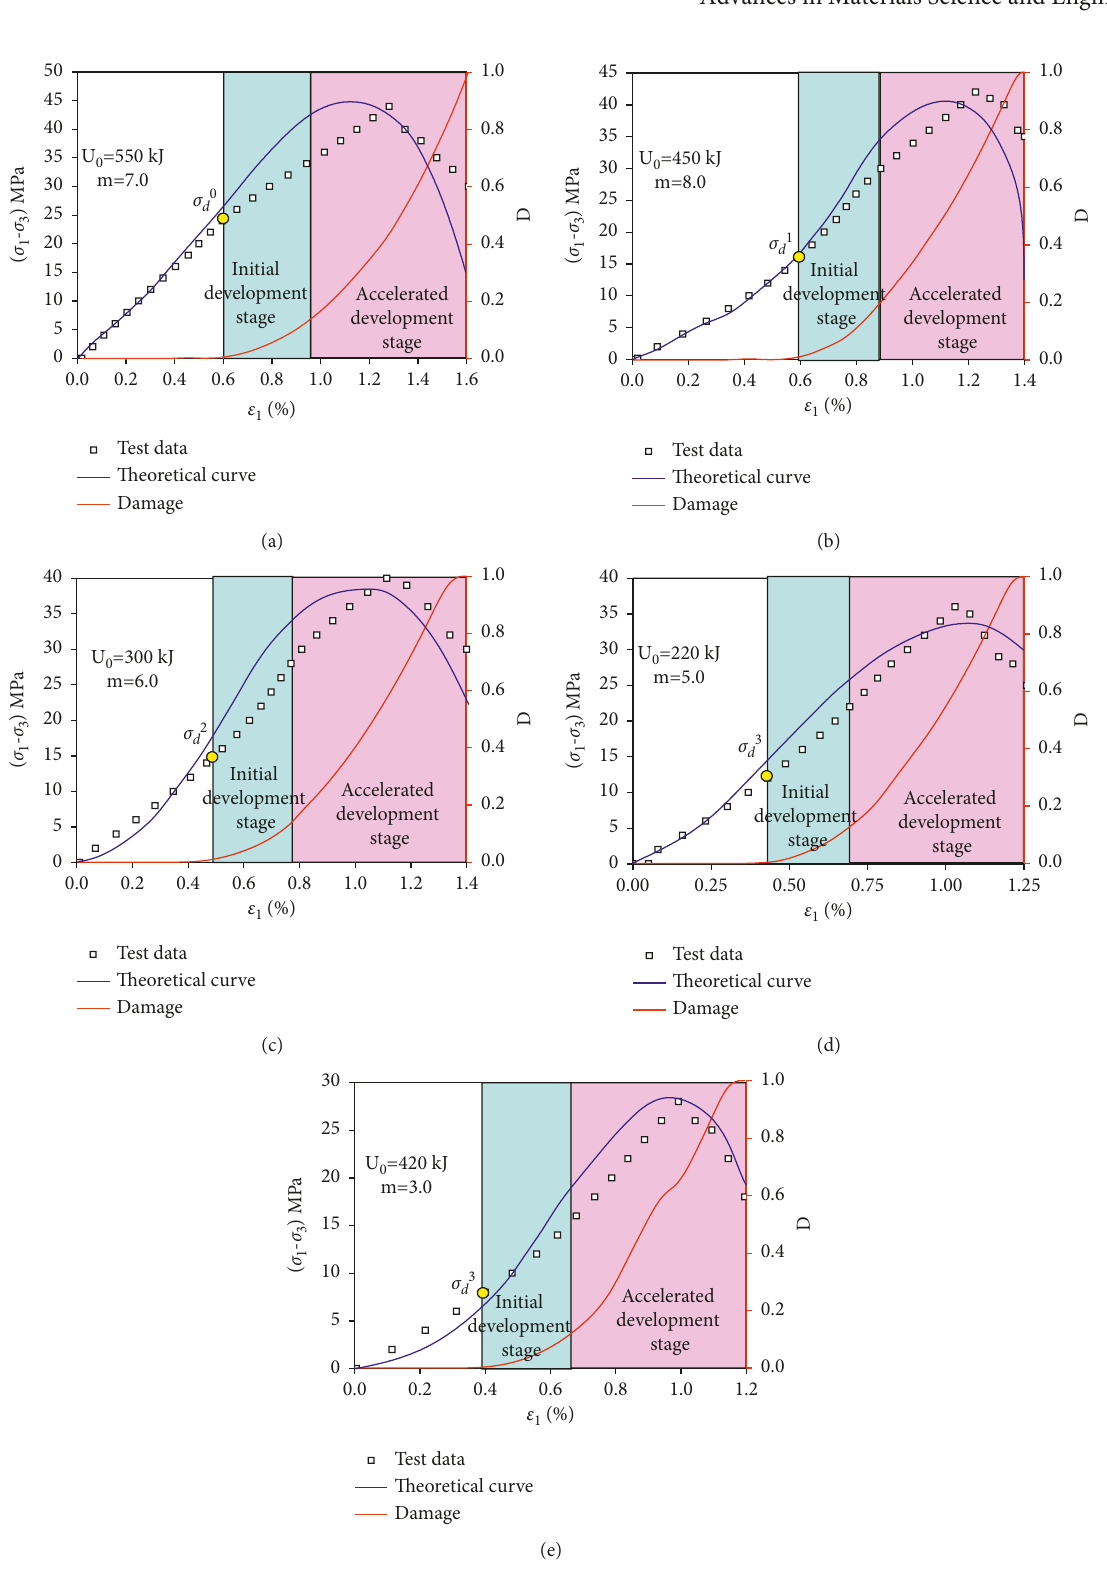
Figure 10: Damage variable of PD rock. (a) S-0 rock sample. (b) S-1 rock sample. (c) S-2 rock sample. (d) S-3 rock sample. (e) S-4 rock